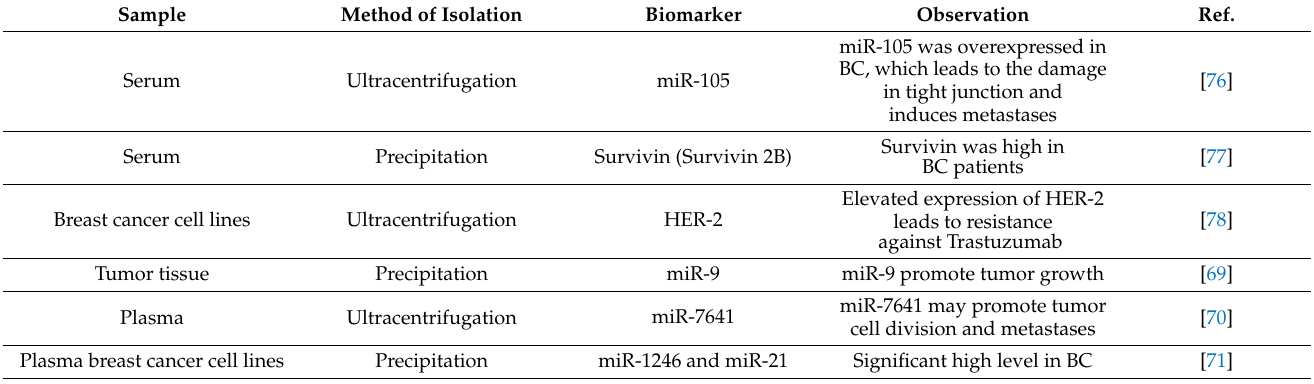
Table 5. Potential exosomal miRNAs and proteins as a biomarker for the diagnosis of breast cancer.